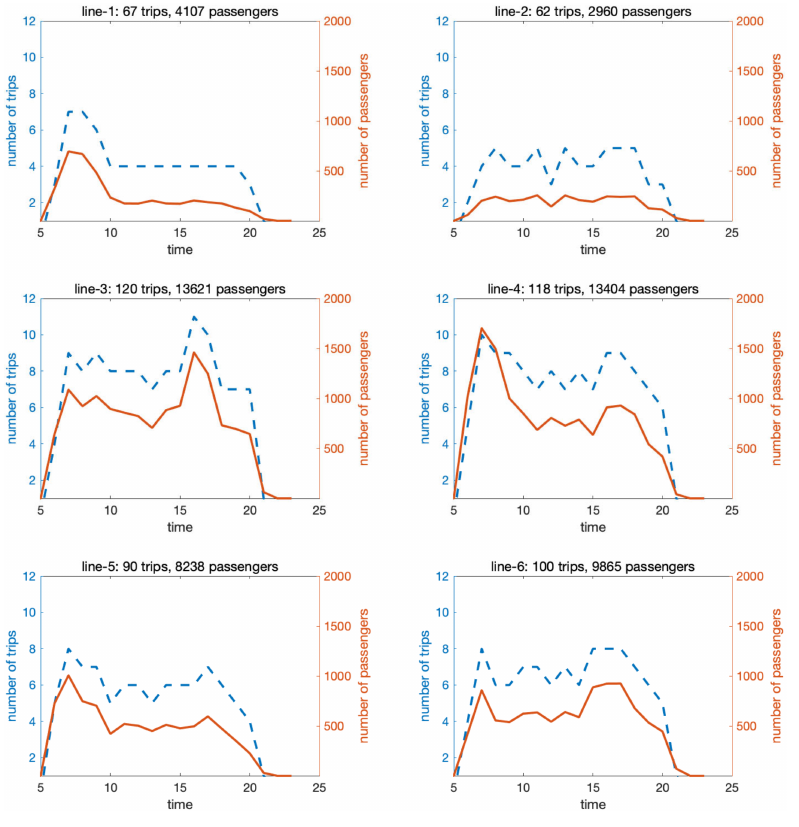
Figure 15. Diagram of demand and supply for each line.